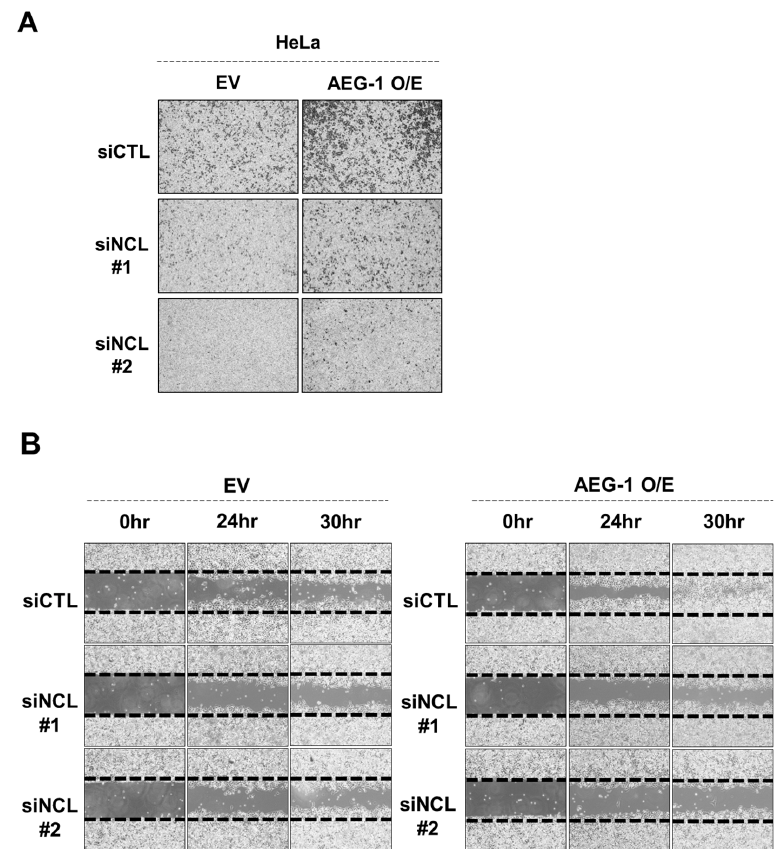
Figure 2. Silencing NCL markedly decreased the migration induced by AEG-1 in HeLa cells. Cells were transfected with indicated siRNAs before the AEG-1-HA or empty vector (EV) plasmids were transfected two days later. Cell migration was analyzed by transwell-based migration assay ( A ) or wound healing assay ( B ). Representative data from three independent experiments with similar results are shown. Validation of transfection and quantitative analyses are shown in Figure S1. O/E: over expression.